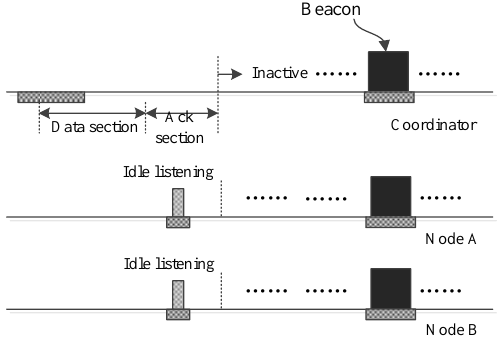
Figure 10. No node sends data to the coordinator.